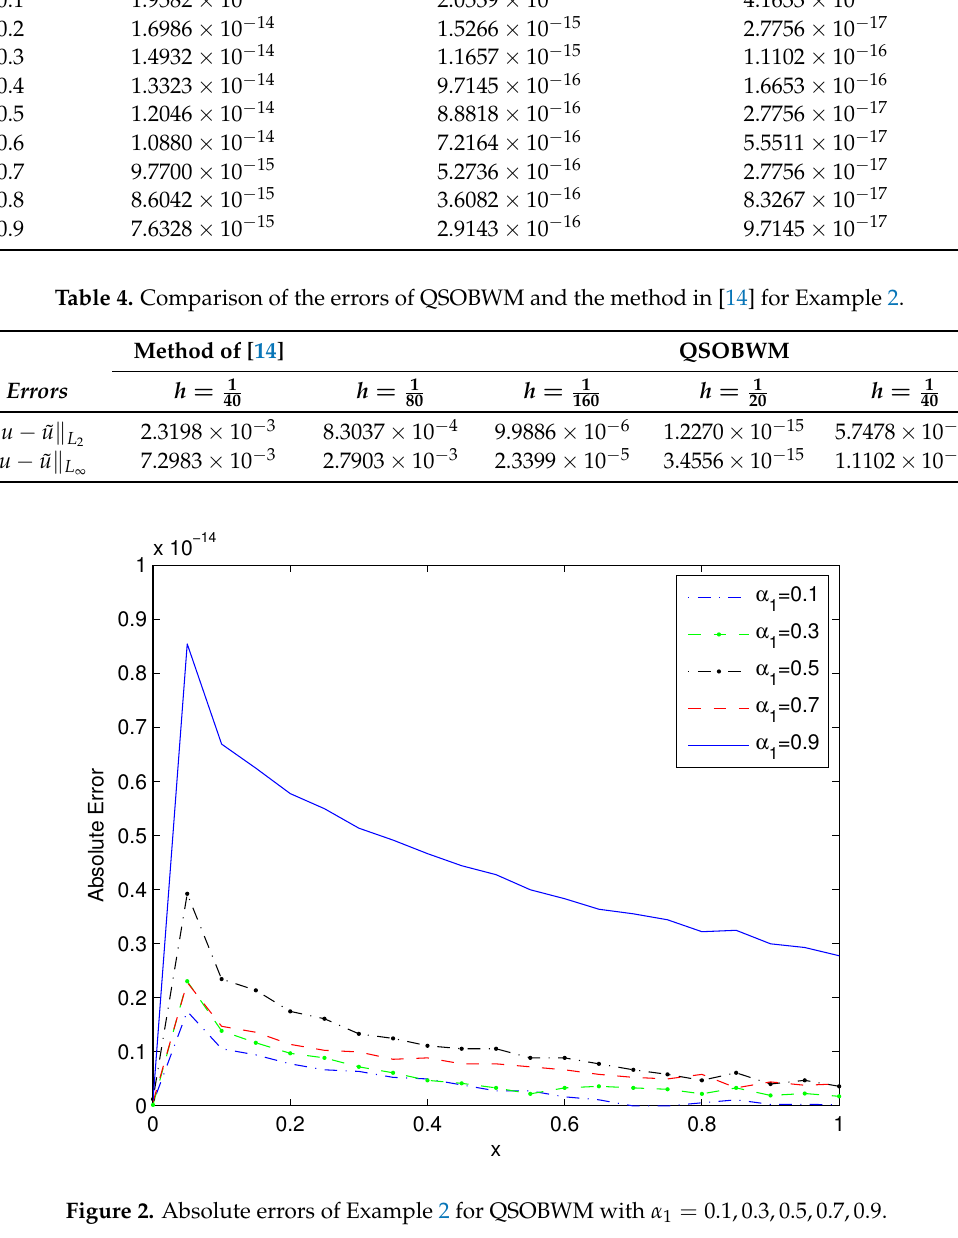
Table 3. Absolute errors of QSOBWM when h = 1